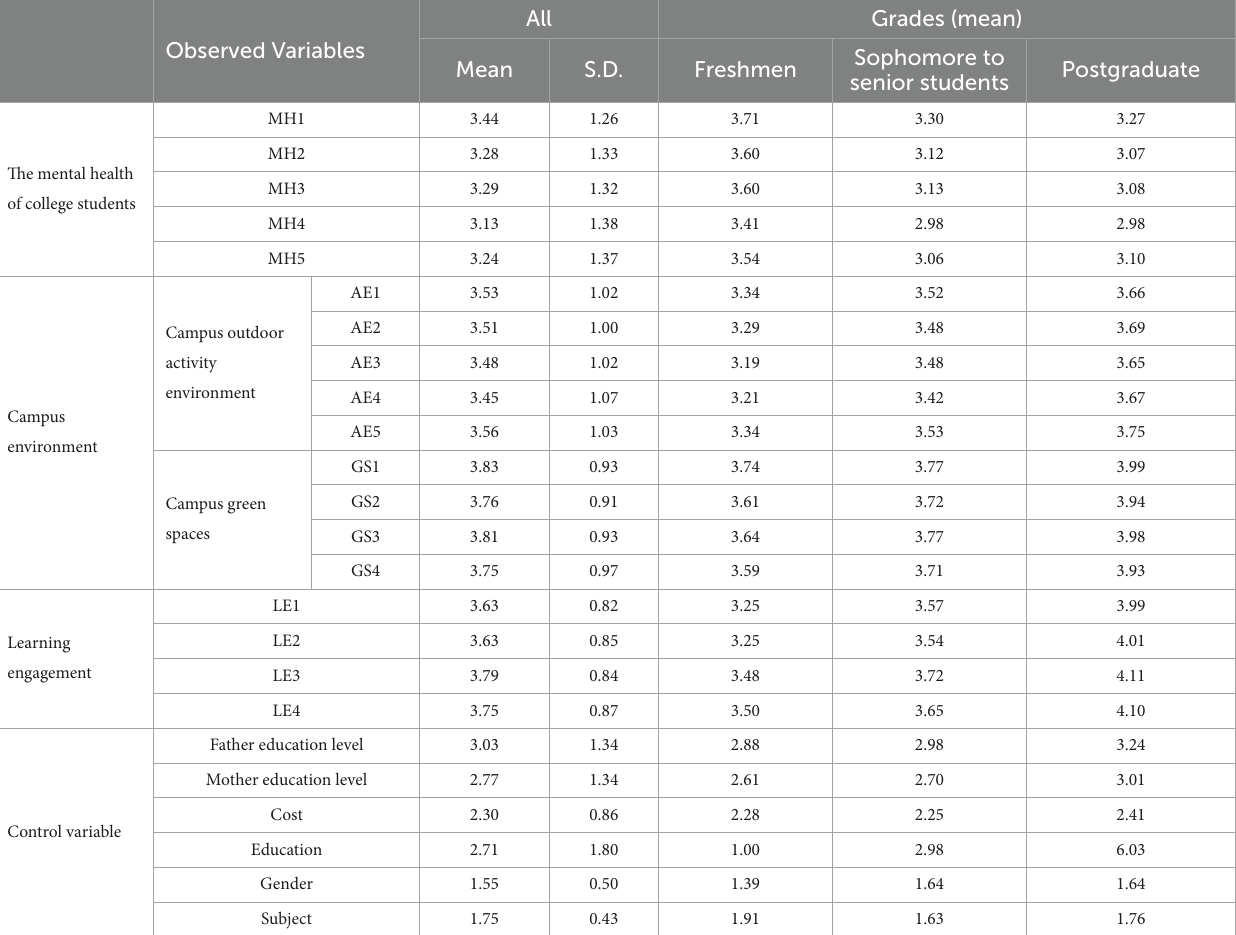
TABLE 5 Variable descriptive statistics.